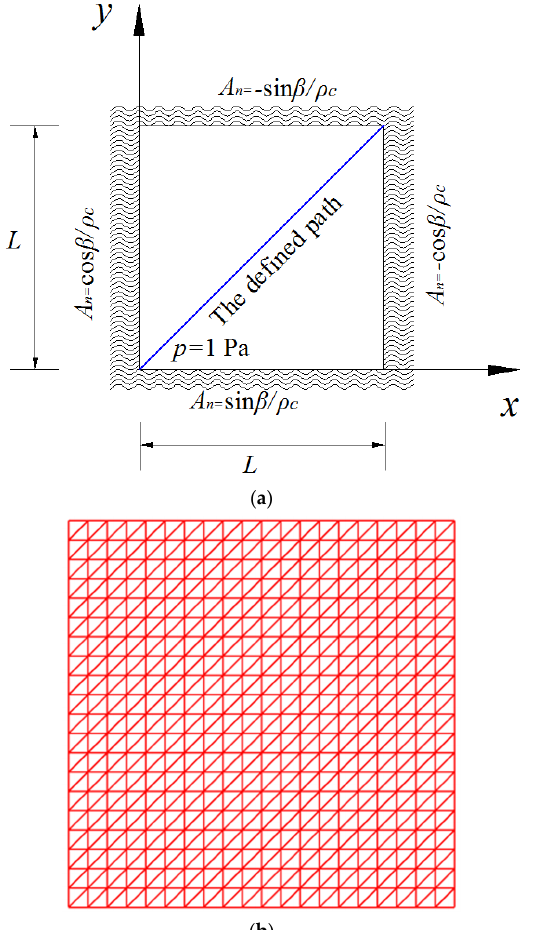
Figure 10. The acoustic propagation in a two-dimensional square domain: ( a ) the geometry parameters of this square domain and the related boundary conditions and ( b ) the employed spatial discretization pa tt ern.